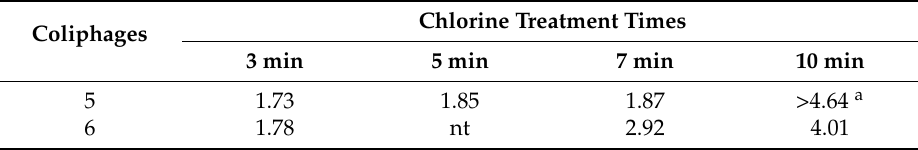
Table 5. Synergy values of coliphages when first treated with 0.1 mg/L chlorine for different times and then UV doses of 22 mWs/cm 2